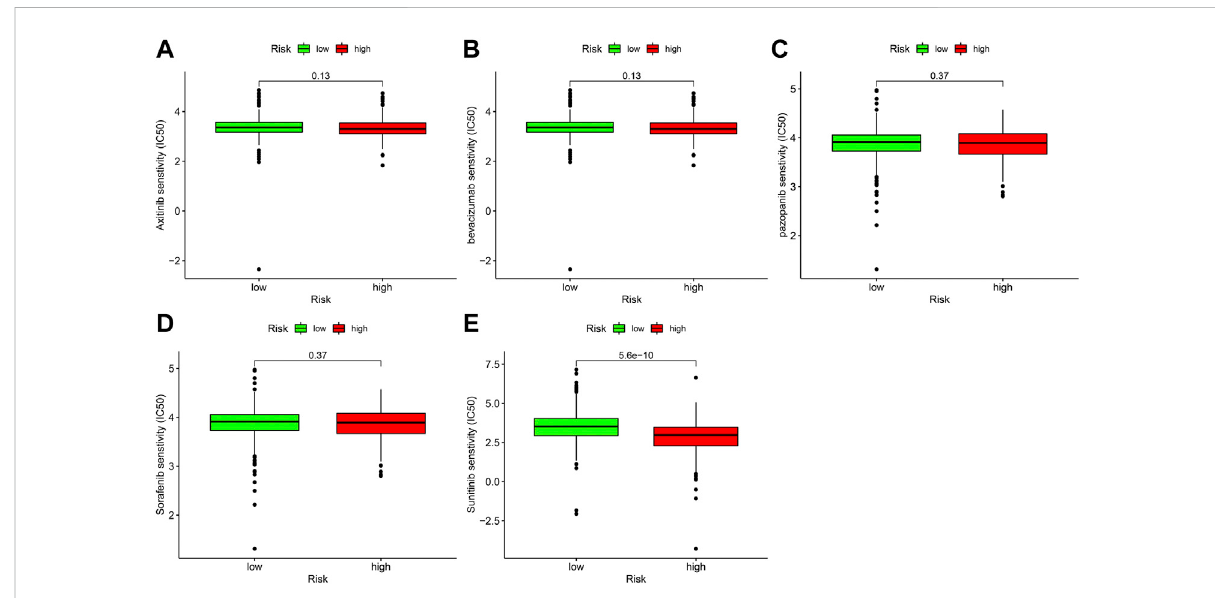
FIGURE 9 The relationship between prognostic signature and sensitivity of targeted drug. (A) axitinib ( p > 0.05), (B) bevacizumab ( > 0.05), (C) pazopanib ( > 0.05), (D) sorafenib ( > 0.05), (E) sunitinib ( p <